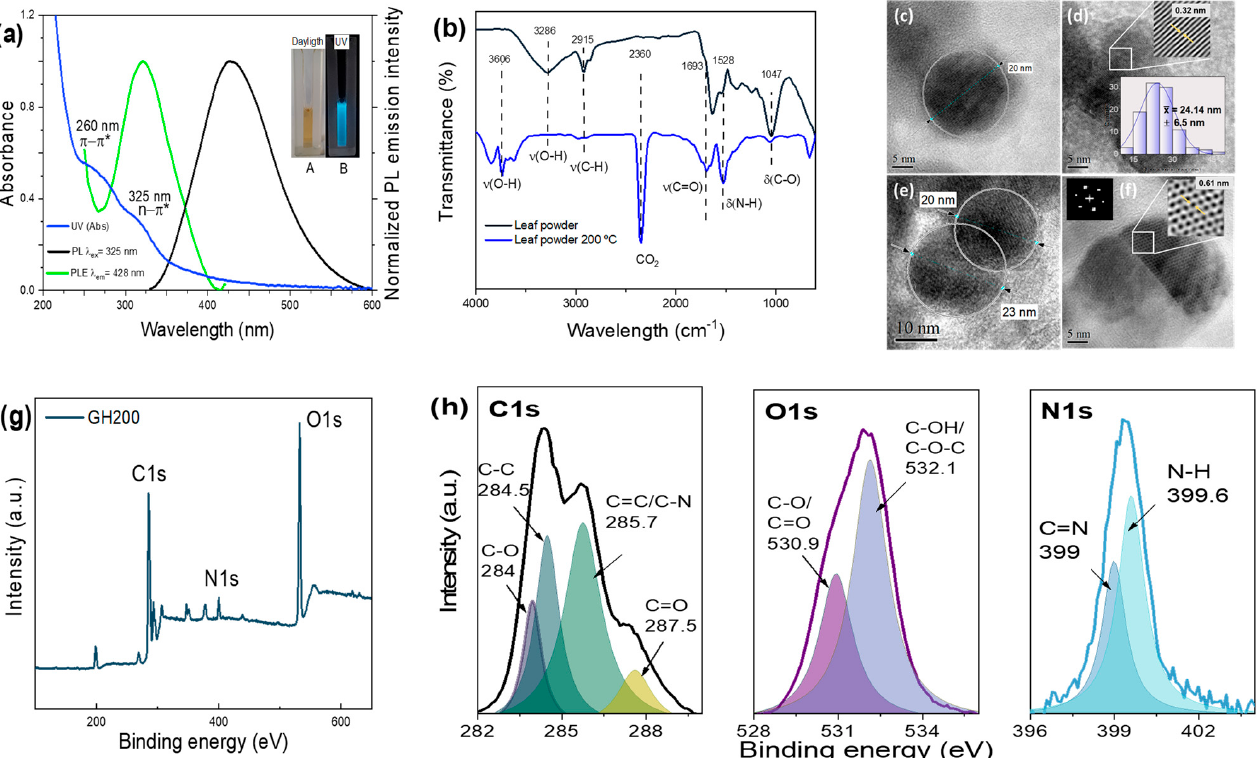
Figure 1. ( a ) Absorbance, photoluminescence (PL) emission, and photoluminescence excitation (PLE) spectra of the synthesized CDs (inset: photographic image of the CDs suspended in water, under daylight (A) and UV light (B)), ( b ) FTIR spectra of raw and carbonized leaves, ( c – f ) TEM micrographs (inset in ( d ) reveal the magnified view of interplanar distance and the particle size distribution), ( g ) XPS survey, and ( h ) high-resolution XPS spectra corresponding to C1s, O1s, and N1s of CDs.